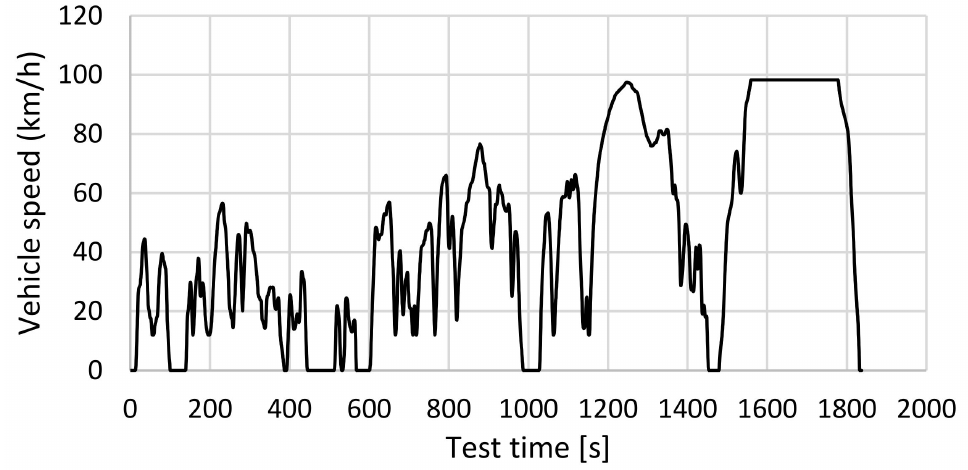
Figure 8. Worldwide Harmonized Light Vehicles Test Cycle (WLTC) legislative test cycle profile with limited maximum vehicle